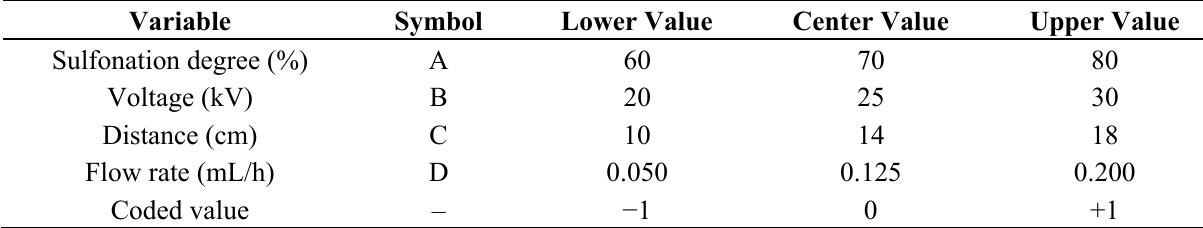
Table 4. Variables chosen for the designed